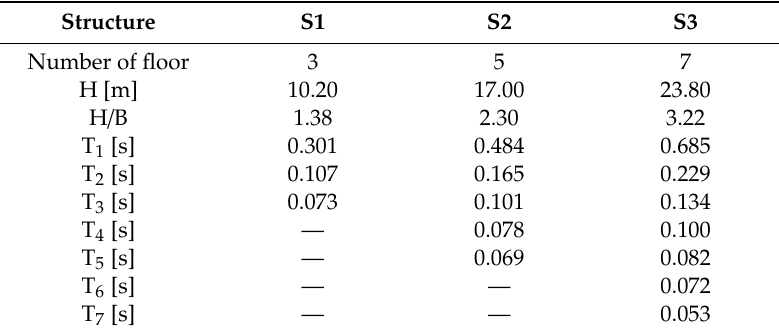
Figure 2. Vertical view: soil (blue); GSI liner (yellow). Table 1. Structural characteristics.